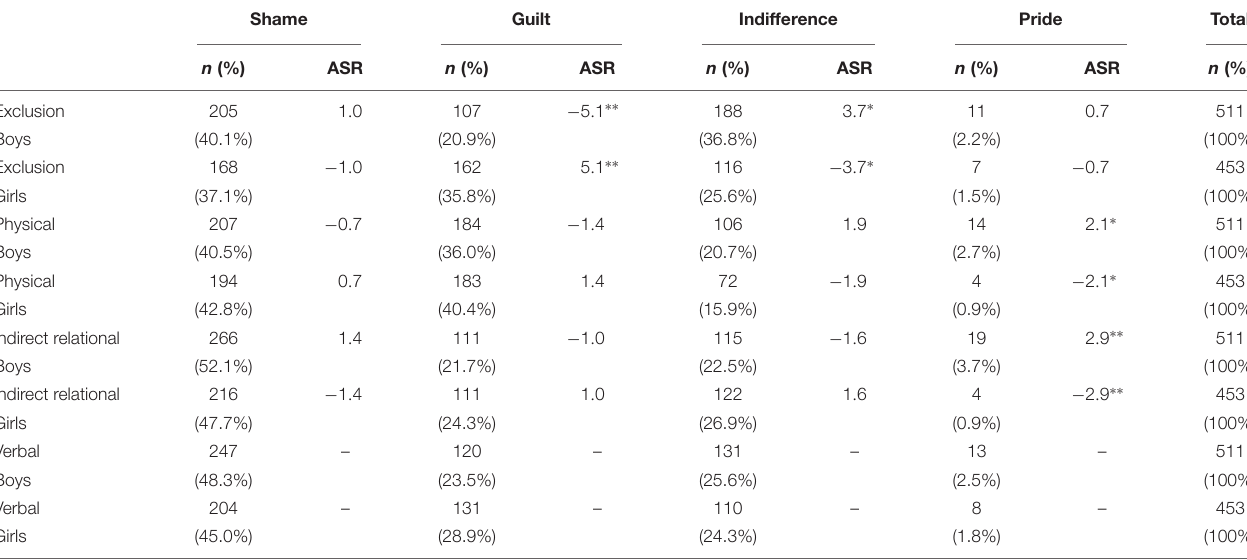
TABLE 8 | Percentages of moral self-attribution and